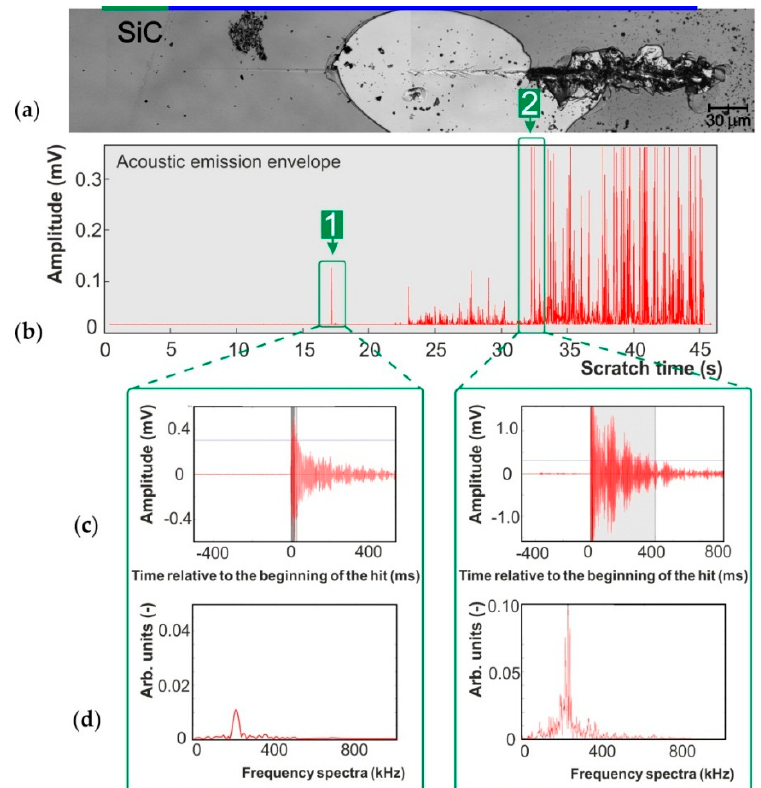
Figure 7. Detailed evaluation of specific observed AE hits. Firstly the microscopic record ( a ) was compared with the envelope of AE record ( b ). Then detailed evaluation in form of hit visualization ( c ) and hit’s spectrum ( d ) of two AE events belonging to the lone film crack (marked “1”) and jointly cracking of substrate and film (marked “2”). Note the different axis scale in both spectra ( d ).